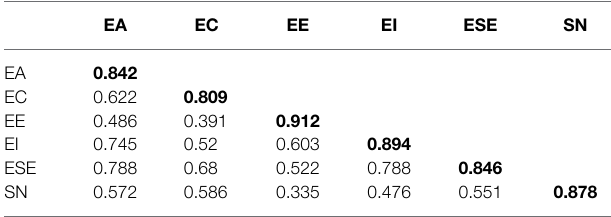
TABLE 5 | Discriminant